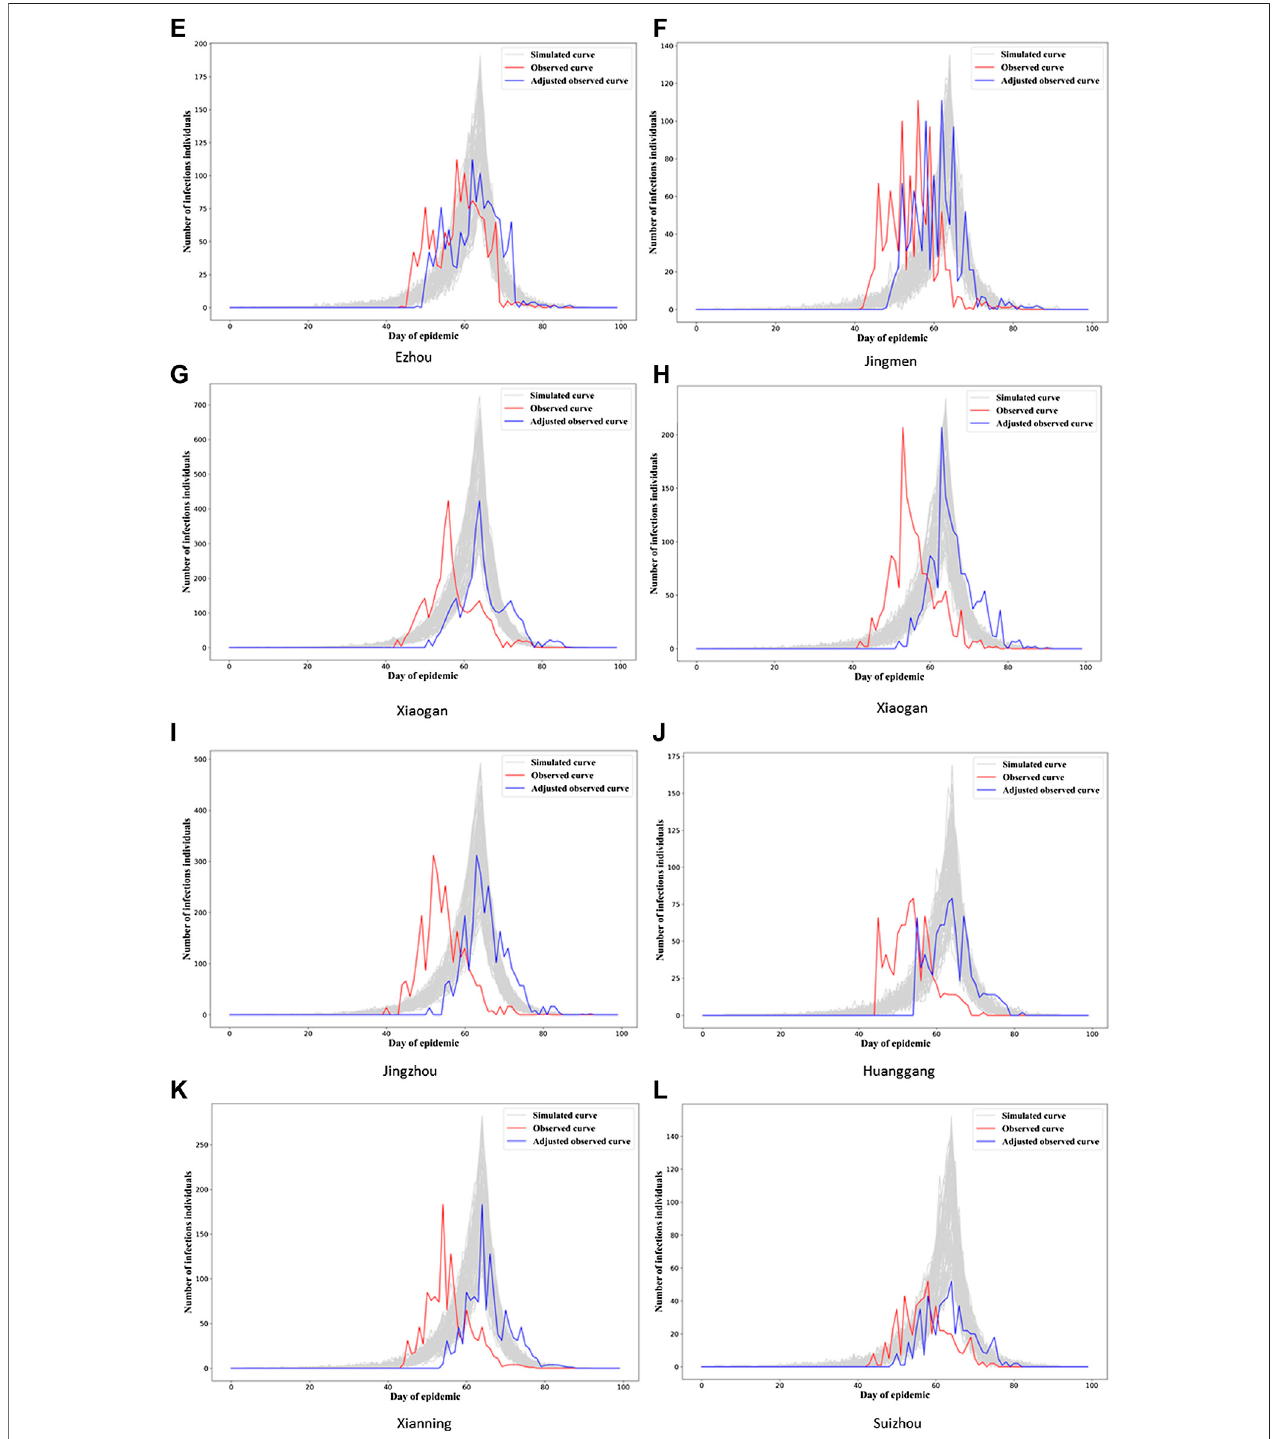
FIGURE 5 | Observed and simulated epidemic curves under fi nal model for eight cities in Hubei (other four cities in Figure 6 ; for Wuhan, see Figure 3 ). Real data shown in red; shifted real data accounting for potential differences in delays to reporting in different cities shown in blue; dark gray curves represent 70% of curves simulated from the fi nal model closest to the true curve.